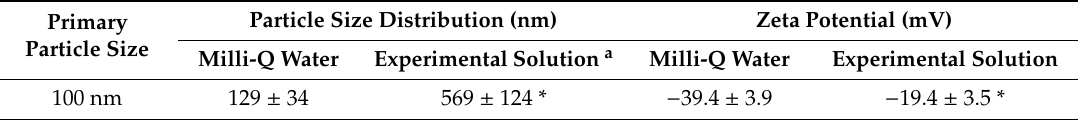
Table 1. Particle size distribution and zeta potential of polystyrene beads.